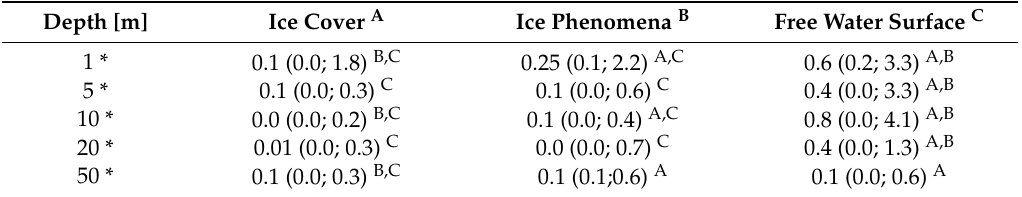
Table 1. Temperature amplitudes in the study terms of 2007 at particular depths in Lake Morskie Oko. Depth [m] Ice Cover A Ice Phenomena